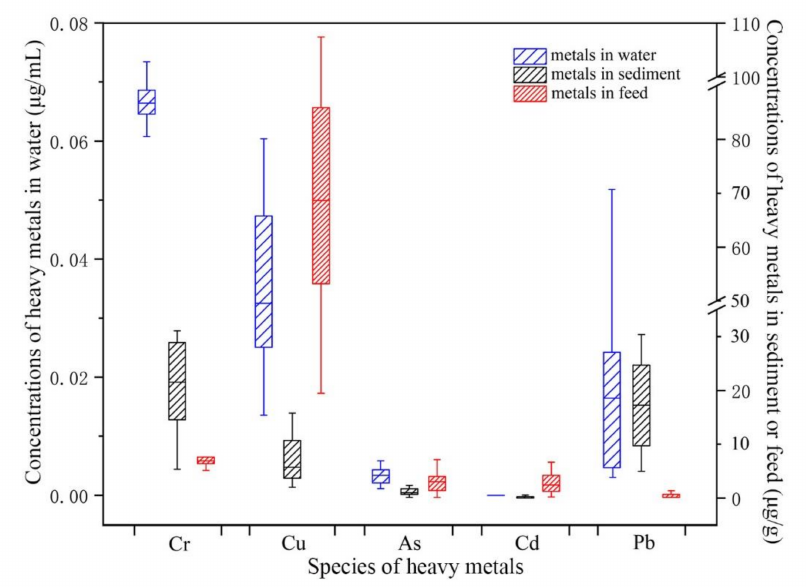
Figure 2. Distribution of the concentrations of five heavy metals in water, sediment and feed.